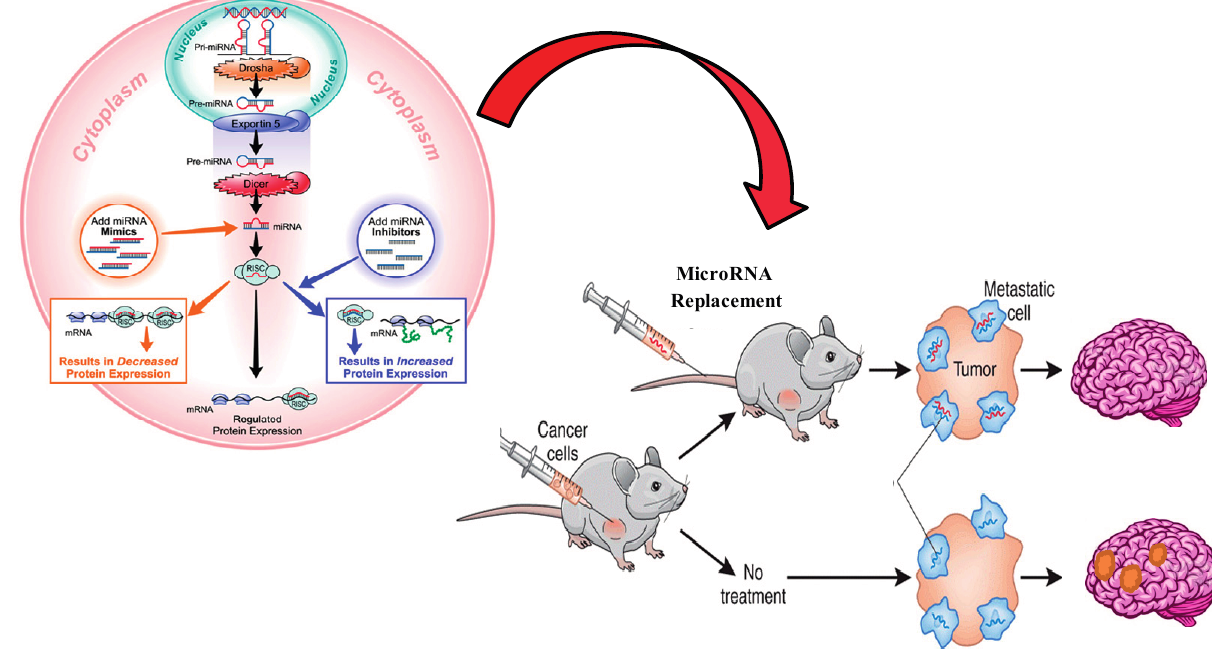
Figure 4. Model to illustrate the effect of microRNA-based therapeutics for the treatment of brain metastases at the cellular and animal levels. Oncology-directed miRNA replacement therapy. Loss of a tumor suppressor miRNA leads to hyperactivation of inherently oncogenic pathways and tumorigenesis. Administration of a miRNA mimic reinstates the function of the missing tumor suppressor miRNA, suppresses oncogenic pathways and cancer cell